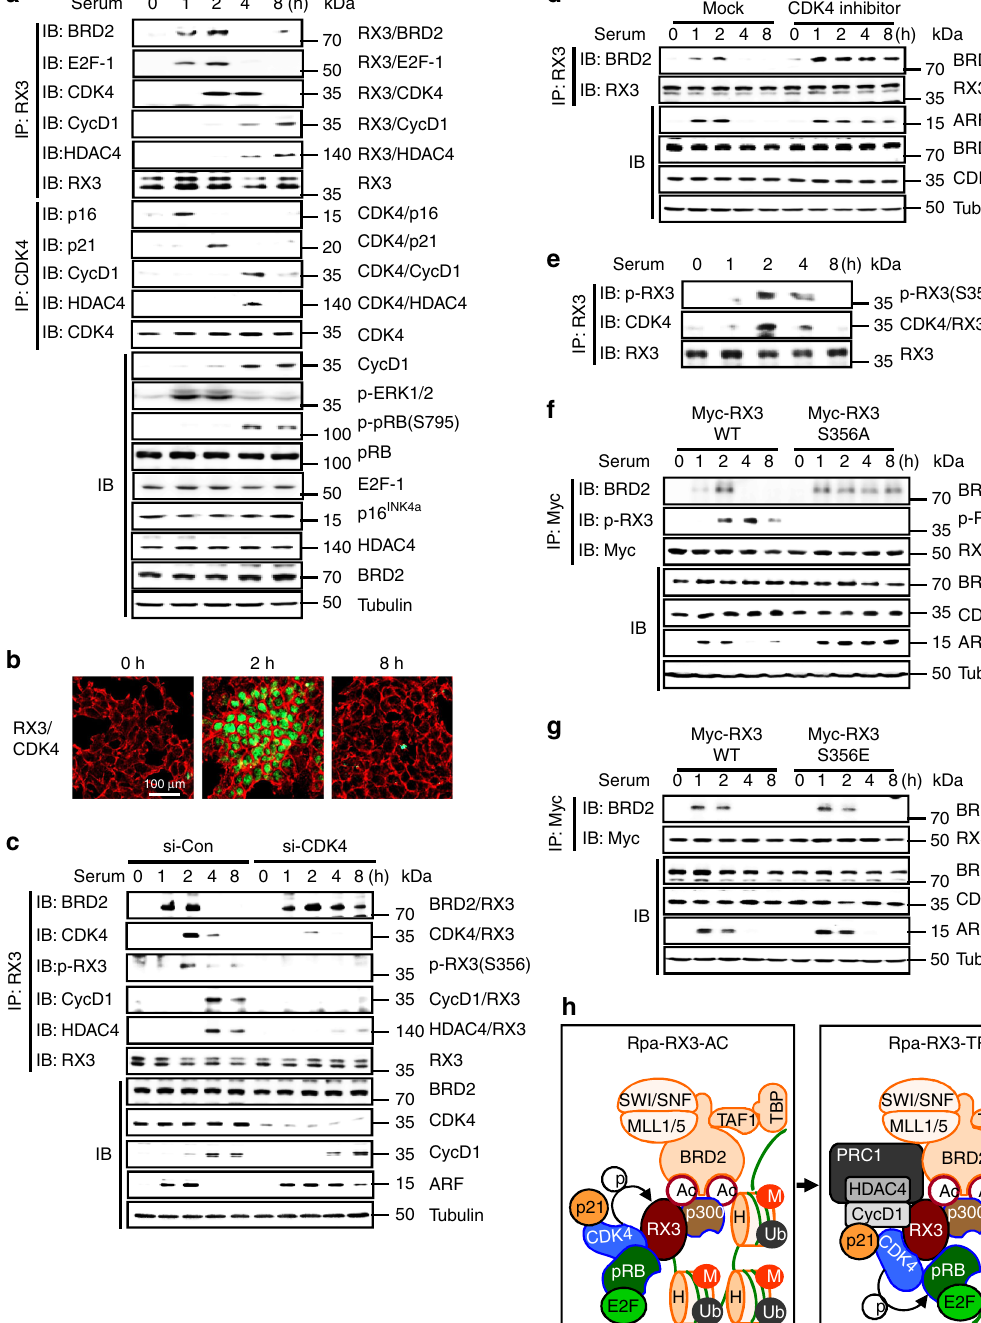
Ser-356 (Fig. 5f). Flag-CDK4-T172A bound to RUNX3 even earlier, and did not dissociate for a long time after serum stimulation (Fig. 5f). Consistently, Flag-CDK4-T172A maintained Rpa-RX3-AC and prolonged ARF expression for up to 8 h (Fig. 5f). These results demonstrate that the JNK pathway also contributes to the R-point transition by activating CDK4. Transcription and translation of Cyclin D1, which plays a key role in formation of Rpa-RX3-TR, are stimulated through the RAS – RAF and RAS – PI3K pathways, respectively 3 . As expected, knockdown of the PI3K catalytic subunit ( PIK3CA , encoding p110 α ) decreased the level of Cyclin D1 and maintained Rpa- RX3-AC and prolonged ARF expression for up to 8 h (Fig.